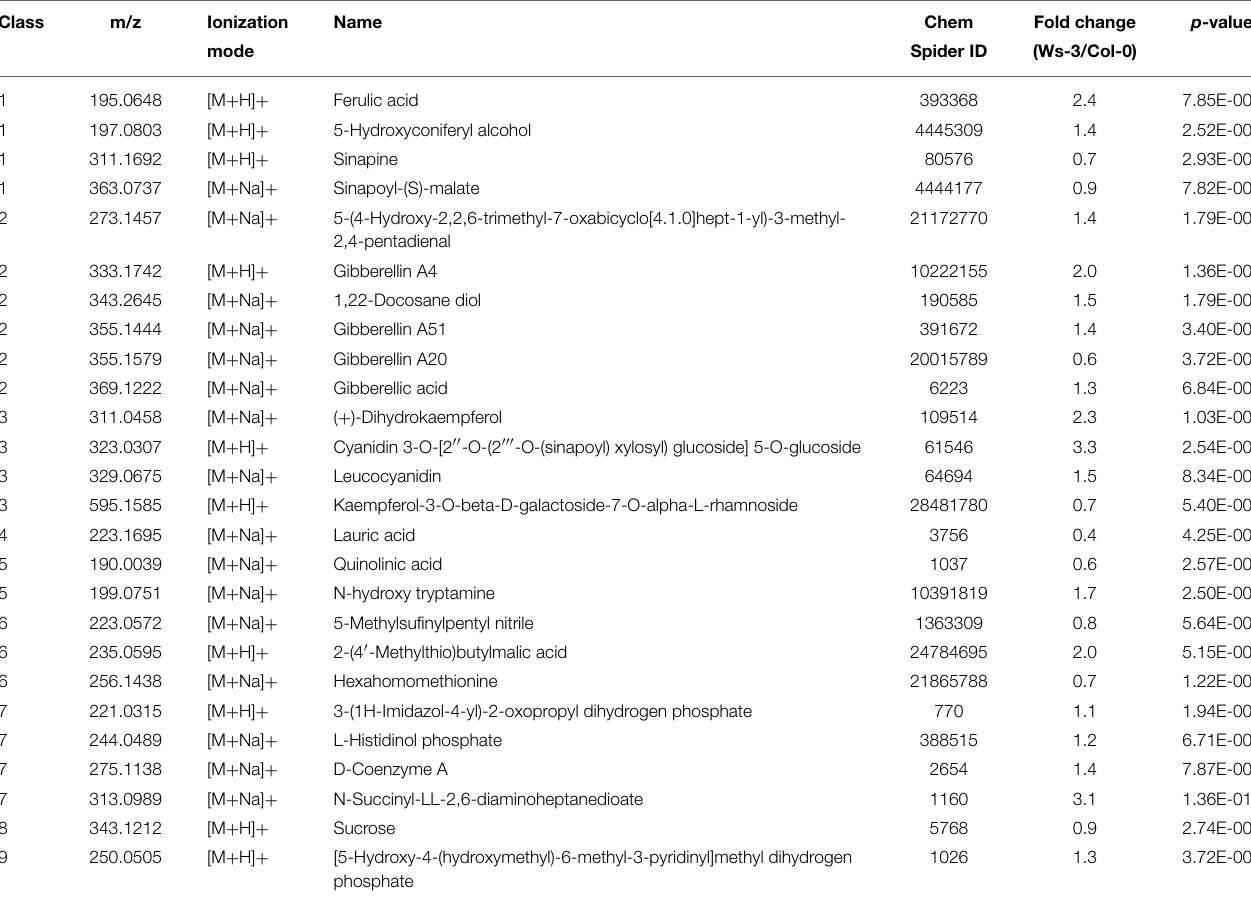
TABLE 1 | Relative amounts of metabolites putatively identified by ACQUITY UPLC-LCT Premier XE (Waters) in crude extracts from leaves of Ws-3 and Col-0 Arabidopsis thaliana